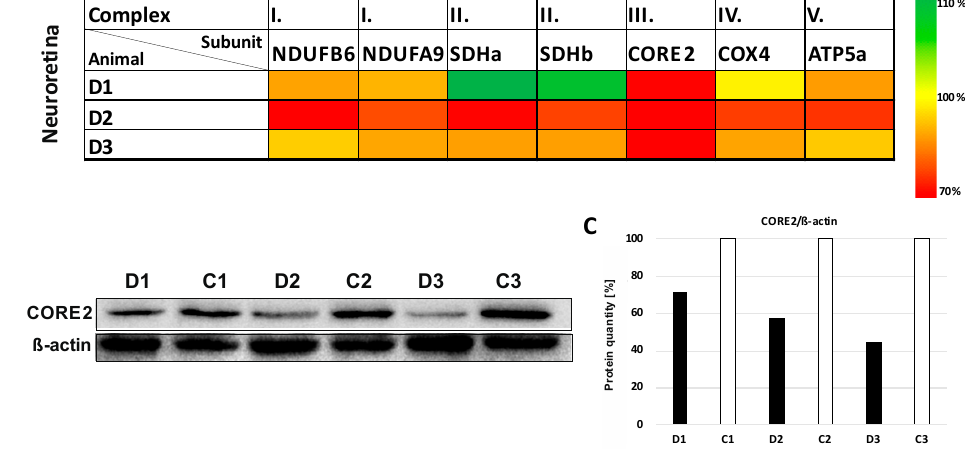
Figure 5. Changes in the protein expression of selected subunits of oxidative phosphorylation system complexes in the neuroretina layer of minipig eyes after high intraocular pressure-induced retinal ischemia. ( A ) The heatmap shows significant reduction in CORE2 protein (structural subunit of complex III). The results of SDS/WB evaluation were normalized to β -actin and compared to the left eyes of each minipig. D1, D2 and D3 are eyes after high intraocular pressure-induced retinal ischemia. The scale on the right shows the degree of the protein level change. ( B ) Decreased level of CORE2 was detected in neuroretina compared to the control samples ( p < 0.0001). Lysates from homogenates of diseased/retinal ischemia (D1, D2, D3) and control (C1, C2, C3) eyes were analyzed by SDS-PAGE/WB. Briefly, 10 µ g of total protein was separated in 12% glycine gel and detected. Representative SDS/WB is shown. ( C ) Quantification of the Western blot signal (shown in panel ( B )). The intensity of the bands was quantified by Quantity One software and their values were normalized to β -actin. Further comparisons of groups (control eyes versus eyes after intraocular pressure-induced retinal ischemia) are shown in Supplementary Figure